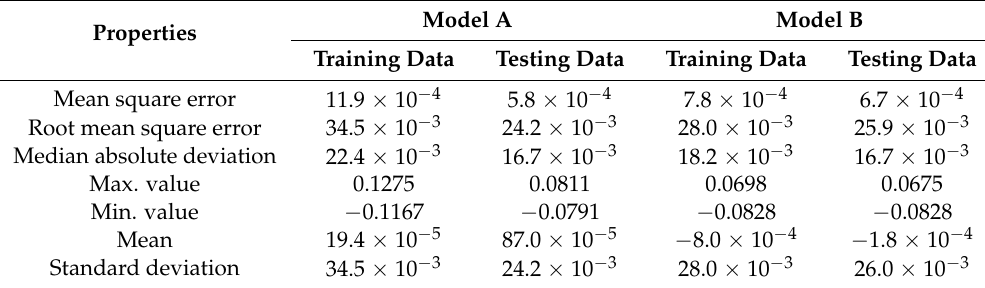
Figure 3. Example of error density function comparison. Table 3. Error validation example.